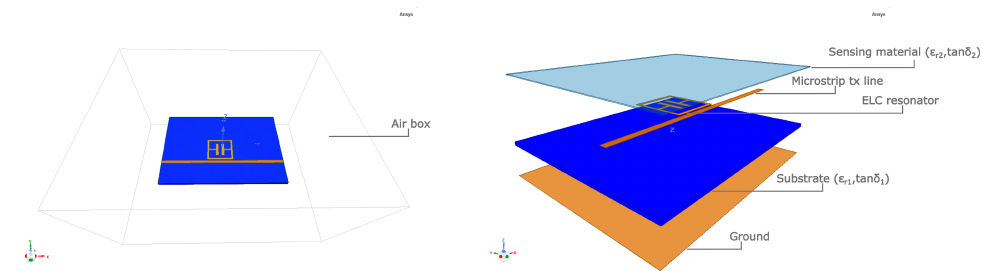
Figure 1. Configuration of the microstripped resonator used in the simulations. The sensitive material covers all the device